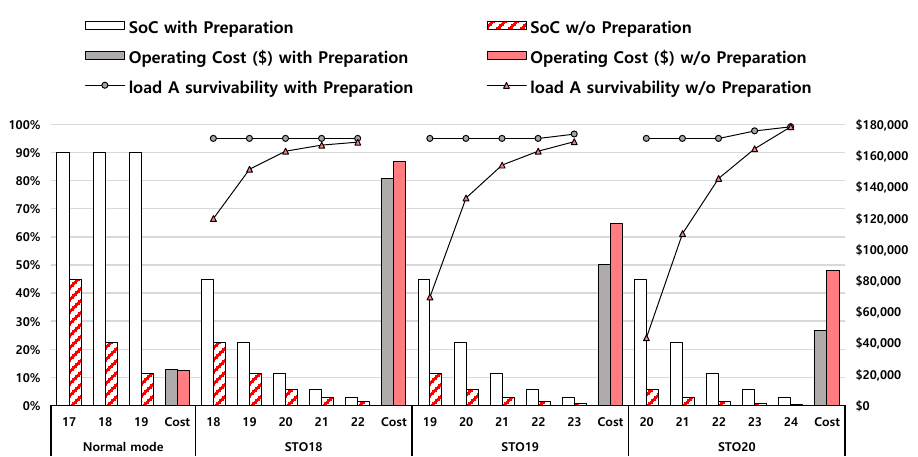
Figure 7. Different components (SoC, load A survivability, and operating costs) of the MG operation in accordance with proactive action at each event period in Case 1.